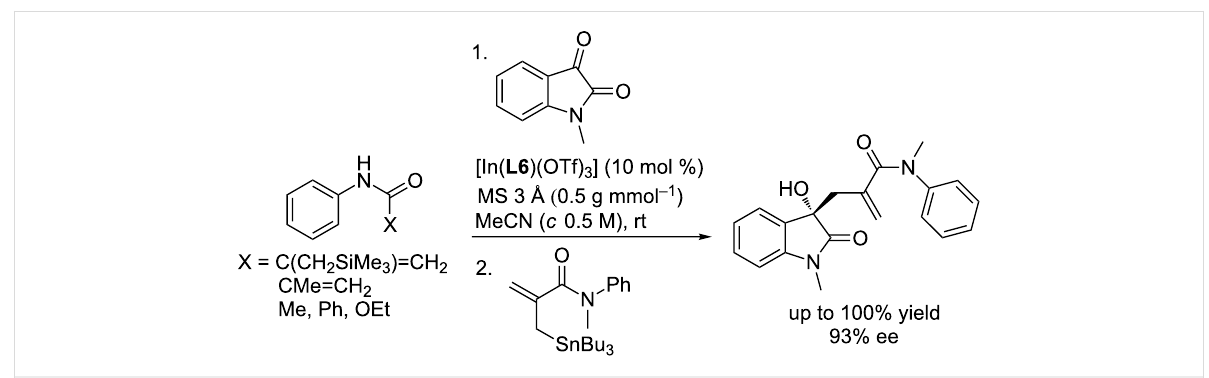
Scheme 14: Modified protocol for the synthesis of allylated